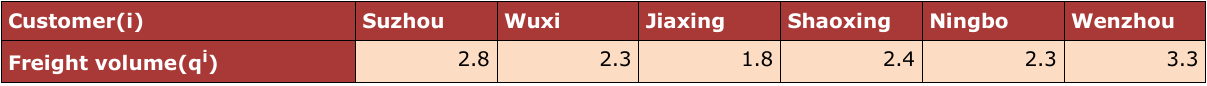
Table 1. Express Demand for Some Cities (Unit: million votes per day)